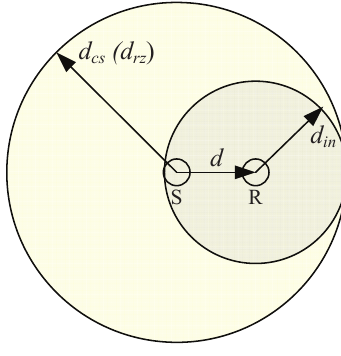
Fig. 2. The relationship between the transmission rate and carrier sensing threshold. The interference range of R should be covered by the carrier sensing reservation zone of S , then hidden terminals around R are